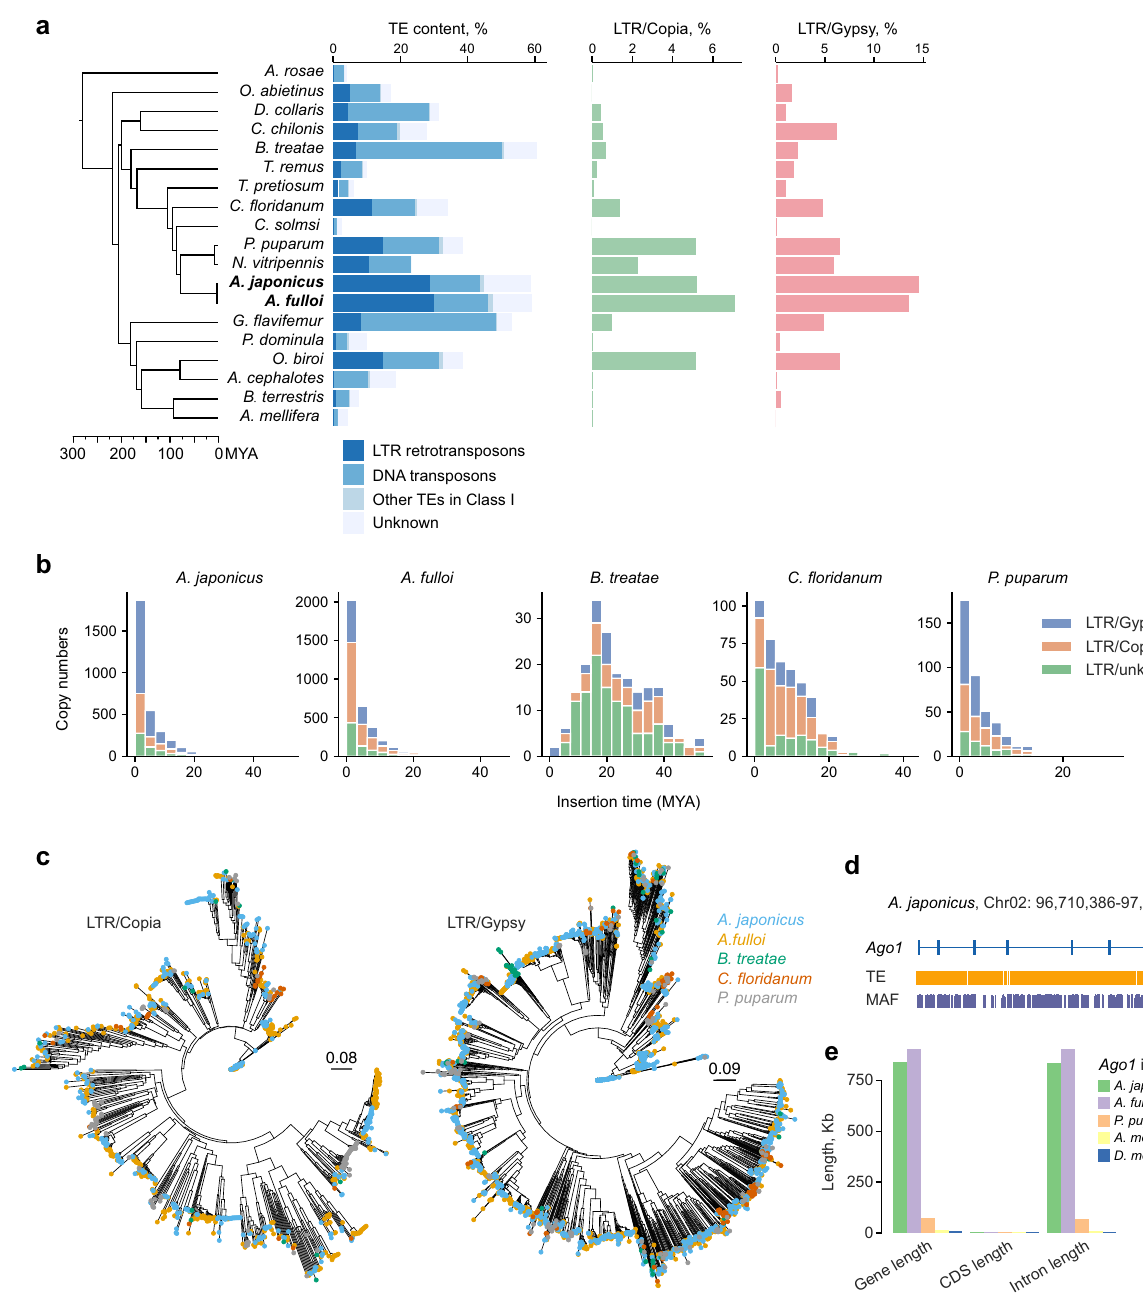
Fig. 2 | Genomesizeenlargement and TEexpansioninthe Anastatus genomes. a ComparisonofTEcontentsinvarioushymenopteranspecies.Theschematictree on the left shows evolutionary relationships and is obtained from Fig. 1c. b Esti- mated insertion time of full-length LTR retrotransposons in fi ve hymenopteran insects. c Neighbor-joiningtreesconstructedusing1439full-length Copia and3140 Gypsy sequences from fi ve hymenopteran insects. d Massive amounts of TE